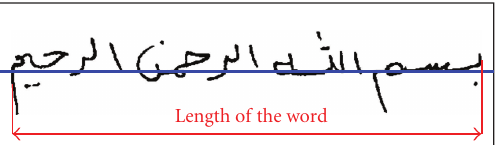
Figure 7: Measuring the length of the phrase.